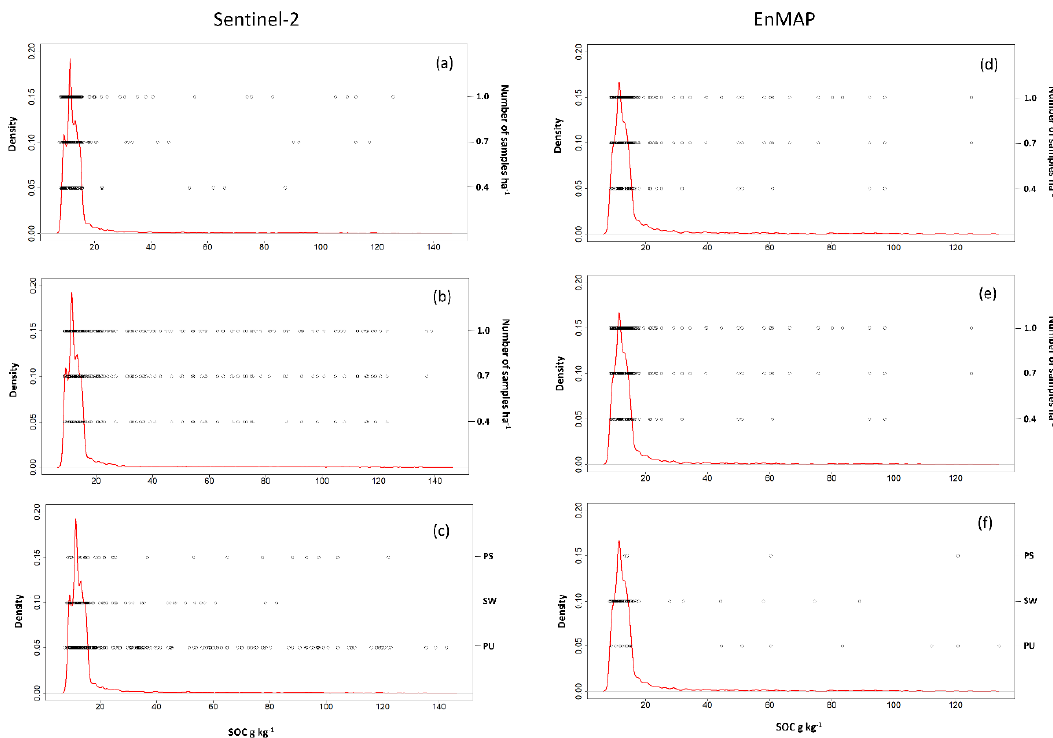
Figure 6. Kernel density estimate plots for the SOC values (field 1, 2 and 3) for the Sentinel-2 (left side) and EnMAP (right side) data. The black circles represent the SOC content of the samples selected by the conditioned Latin hypercube ( a and d ) and the Kennard-Stones ( b and e ) algorithm for different sampling densities. The samples selected by the Puchwein (PU), SELECT (SW) and Puchwein+SELECT (PS) algorithms were shown at the bottom ( c and f ).